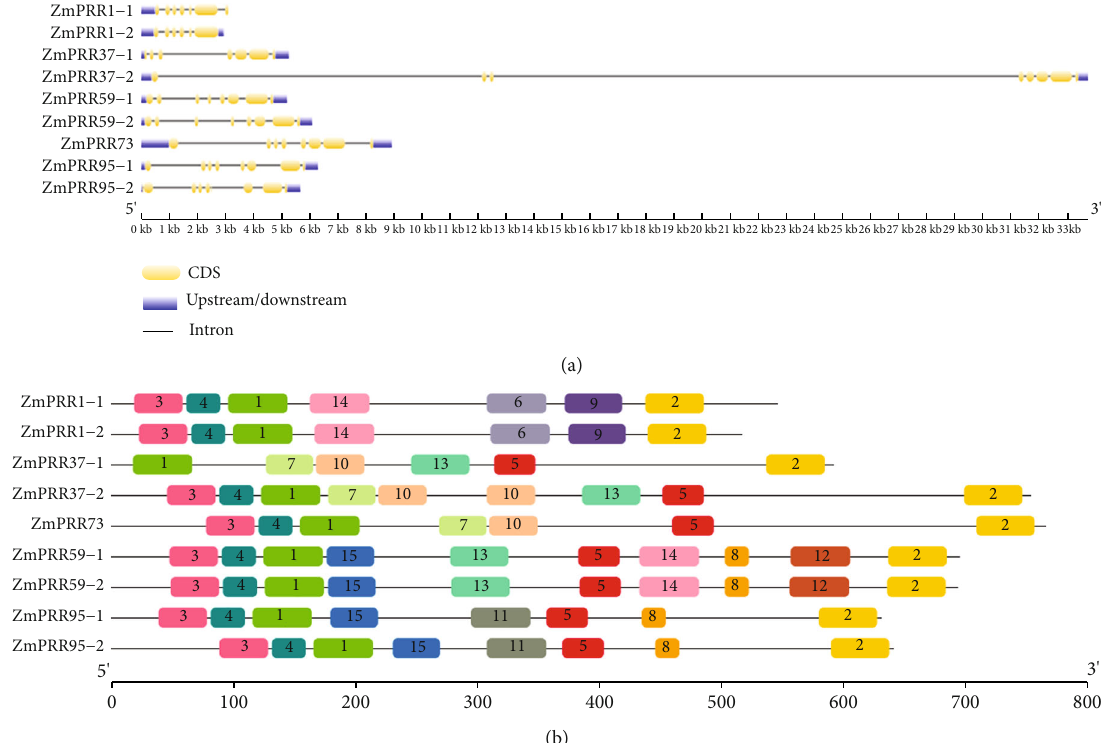
Figure 4: Distribution of exon-introns and conserved motifs of PRR genes in maize. (a) Phylogenetic relationship and distribution of exon/ introns of PRRs in maize; (b) conserved motif predicated in ZmPRR proteins; the ZmPRR proteins are listed on the left. The solid black line represents the corresponding ZmPRR protein and its length. The di ff erent-colored boxes represent di ff erent motifs and positions in each ZmPRR protein